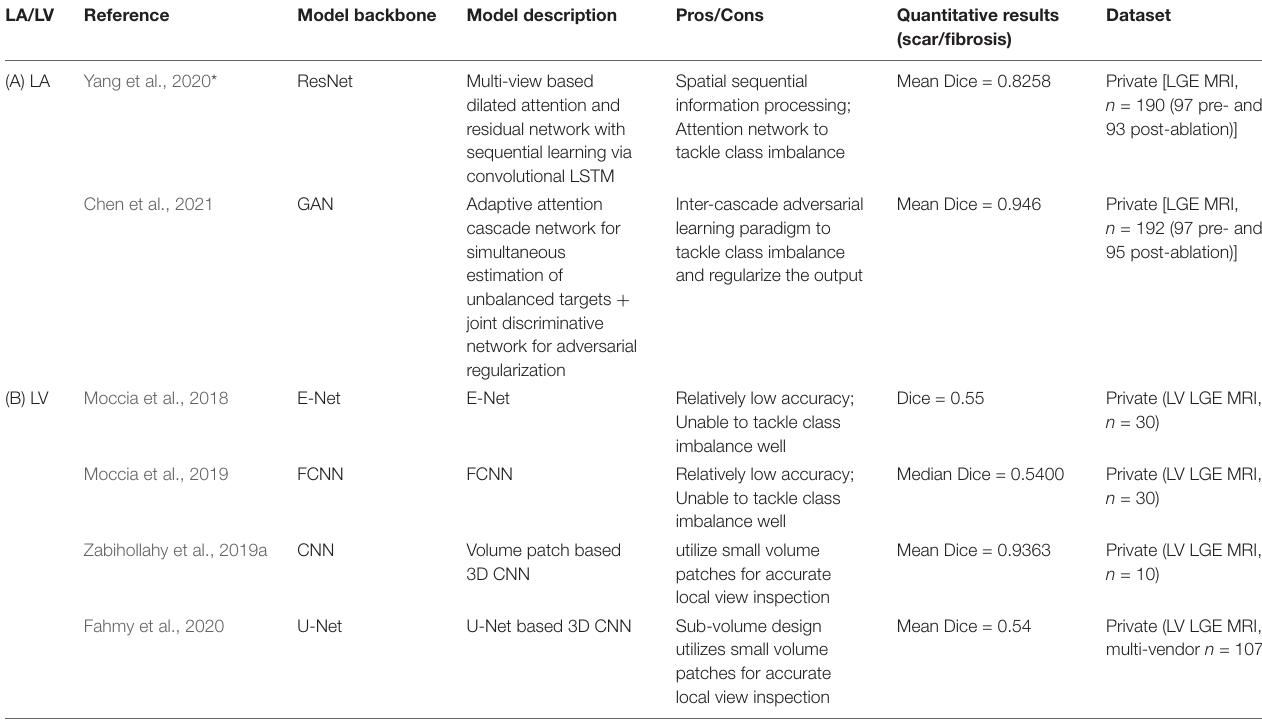
TABLE 6 | Summary of representative end-to-end deep learning based methodologies for segmentation of cardiac scar and fibrosis regions on LGE-MRI.